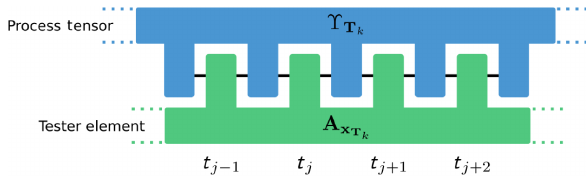
FIG. 20. Action of a process tensor on a tester element. “Con- tracting” a process tensor (depicted in blue) with a temporally correlated measurement, i.e., a tester element (depicted in green), yields the probability for the occurrence of said tester